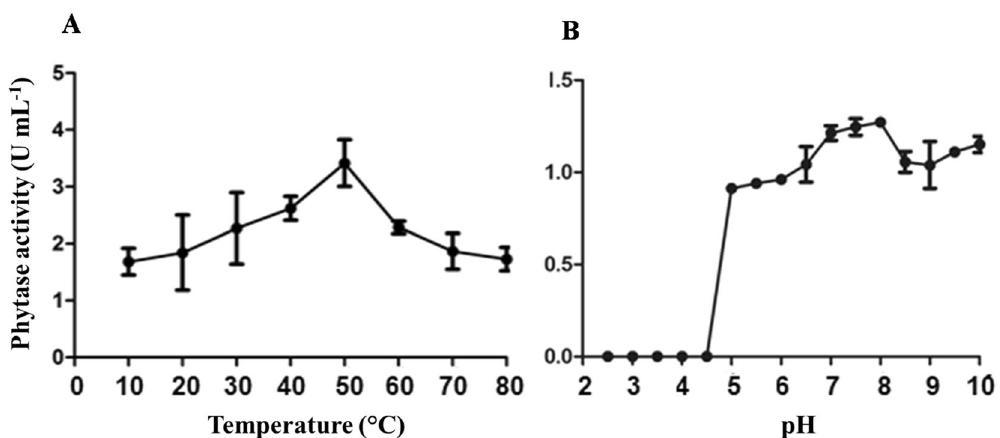
Figure 6. Phytase activity in Acremonium zeae B extracts at different temperatures ( A ) and pH values ( B ). The bars correspond to the standard deviations of the means (n =